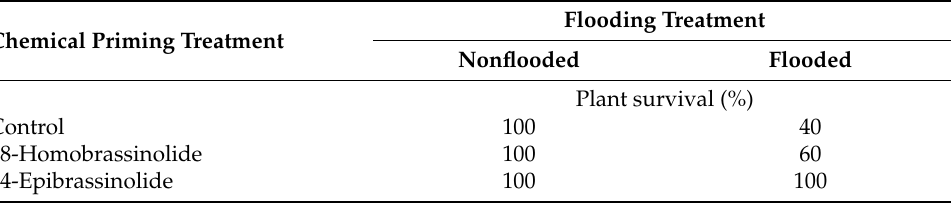
Table 2. Survival of ‘Monroe’ avocado seedling trees treated with brassinosteroids and either flooded or nonflooded (Experiment